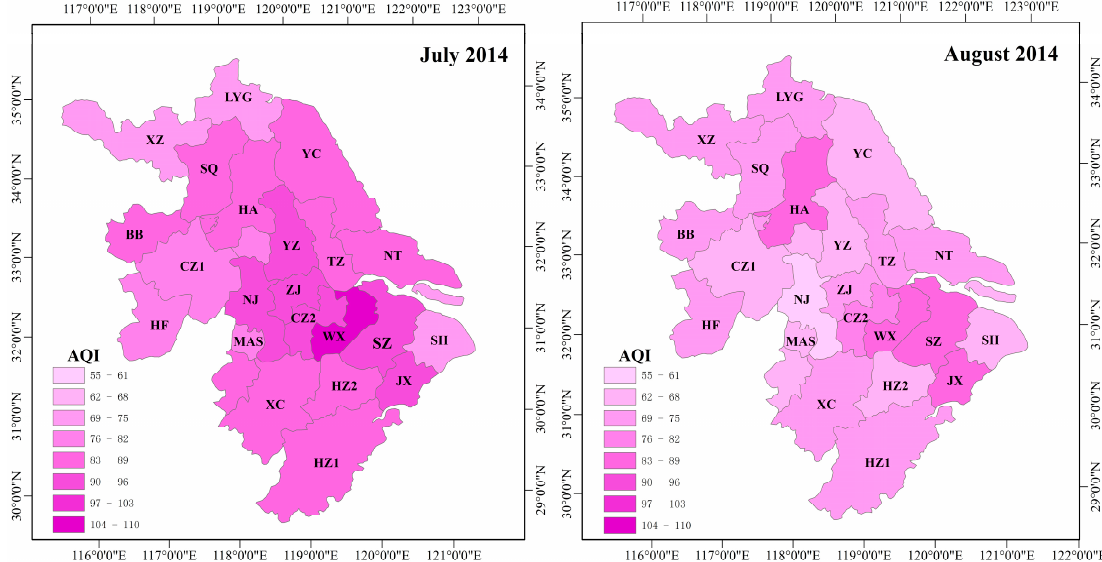
Figure 5. Variation of the AQI in Nanjing and its surrounding cities during the emission reduction period.